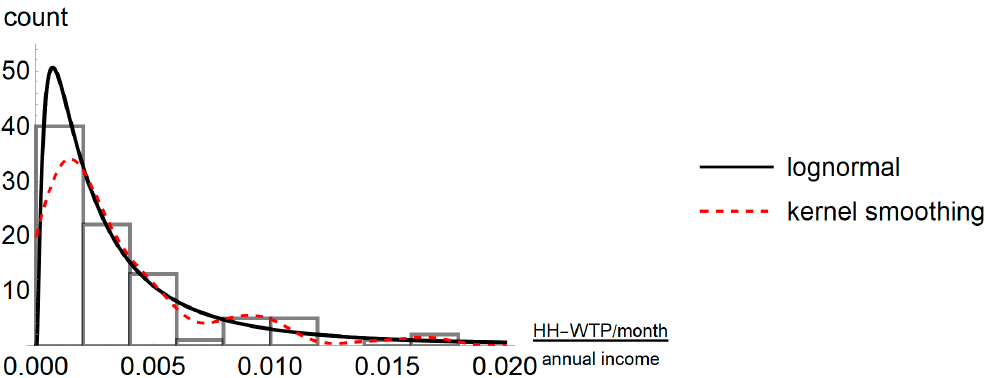
Figure 8. Histogram of the positive WTP/month of HHs as a fraction of annual HH-income from the Raisen 2015 survey (93 data) and related probability density functions: lognormal distribution (black) with maximum likelihood parameters m = − 6.01, s = 1.12 and smooth-kernel distribution of the data (dashed red). To obtain comparable scales these were multiplied with 0.186 (93 data times 0.002 bin width); plot and computations using Mathematica 11.3.